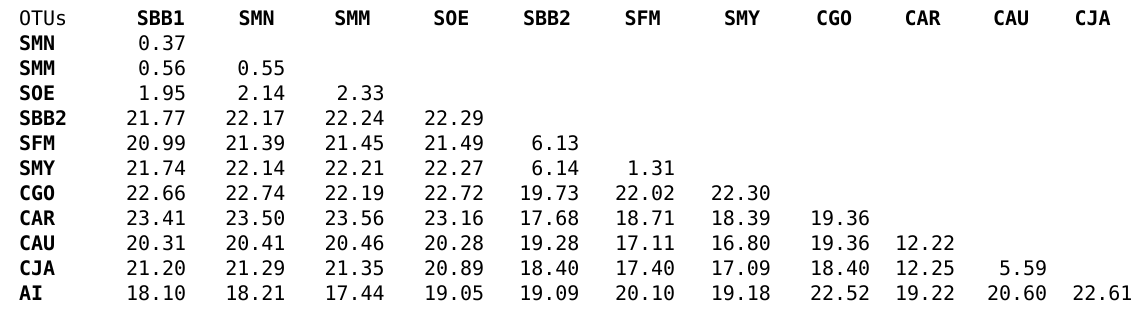
Figure 4 - Genetic divergence calculated using the algorithm of Tamura and Nei (1993). For abbreviations, see legend to Figure